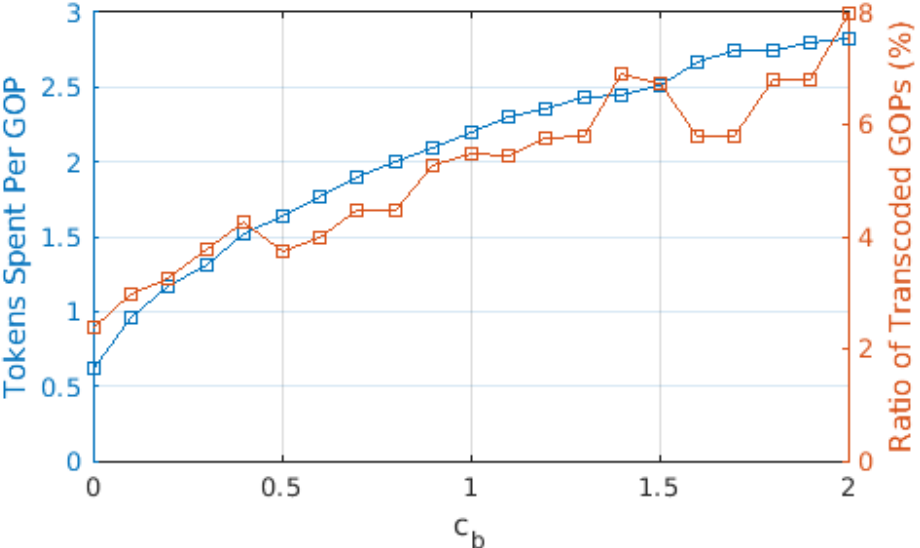
Figure 6. Tokens paid per GOP for different values of c b